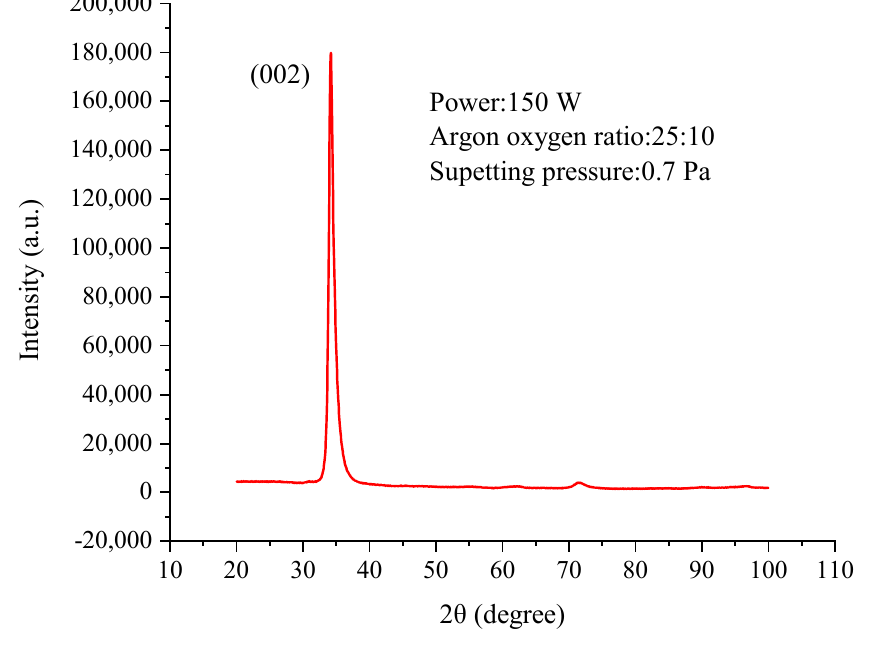
Figure 9. XRD spectrum of ZnO thin films.